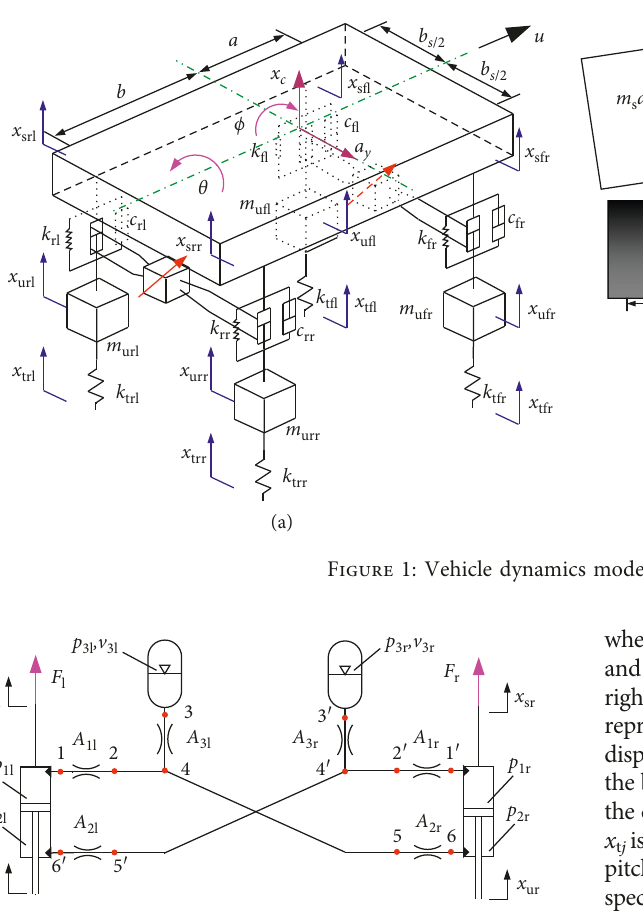
Figure 2: Hydraulically interconnected